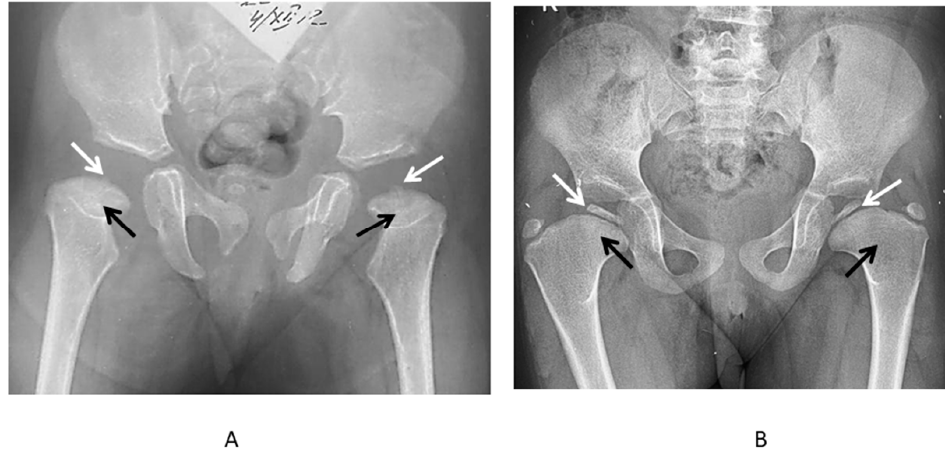
Figure 4. Early radiological changes in the hip joints of the patients with MED type 4. ( A ) Antero- posterior radiograph of the hips of the two 5-year-old patients: remarkably delayed ossification of the epiphyses of the femoral heads (white arrows), shortening of the femoral necks (black arrows). ( B ) Anteroposterior radiograph of the hips of the 6-year-old patient: abnormal ossification (dimin- ished size and flattening) of the epiphyses of the femoral heads (white arrows), shortening of the femoral necks—“cervical coxa vara” (black arrows).